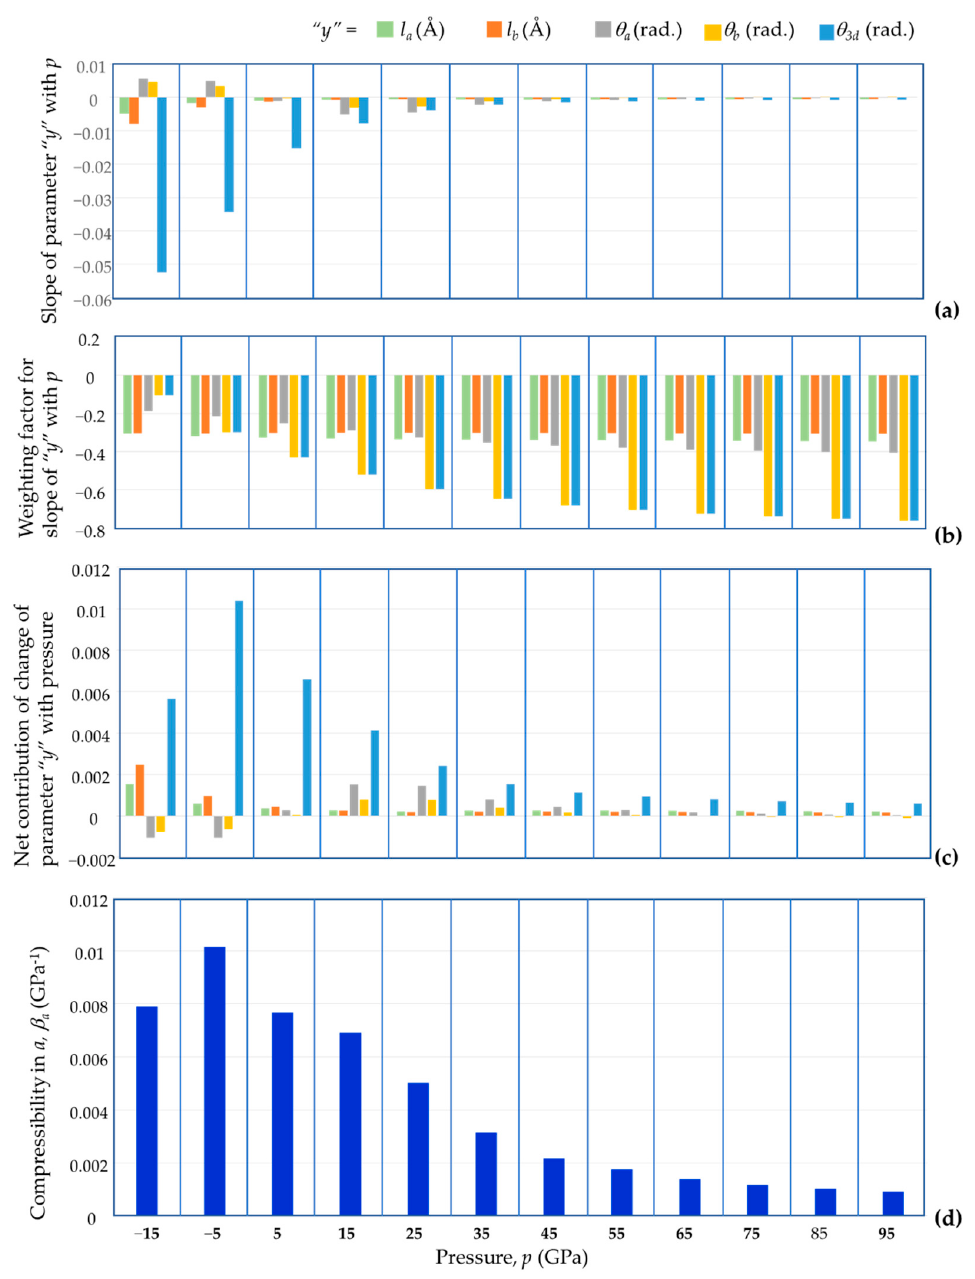
Figure 15. A graphical report of the different components ( a ) slope of parameter y , ( b ) weighting factor of y , and ( c ) net contribution of change in y , which contribute to ( d ) the compressibility in the a direction (similarly for the b direction).